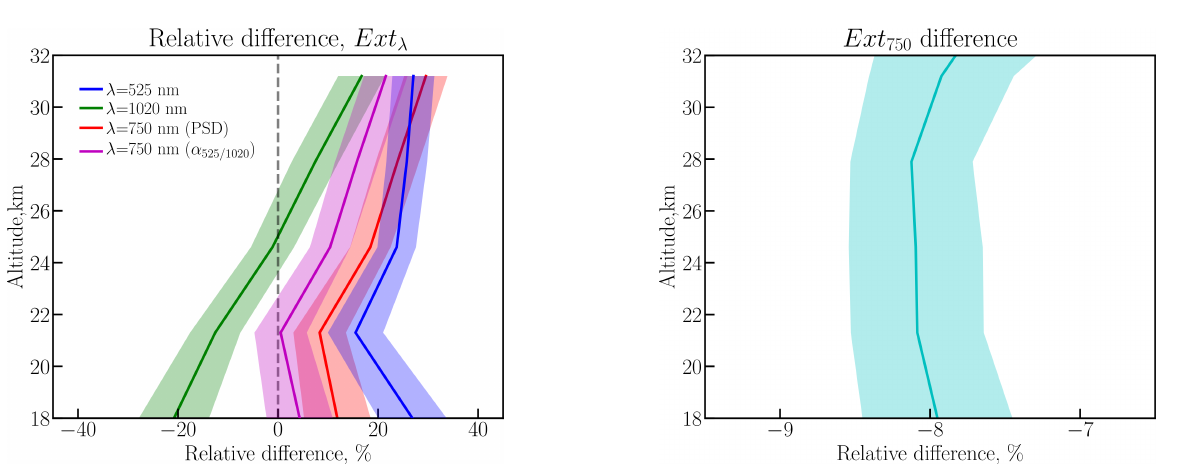
Figure 6. Mean relative difference between Ext 750 ( PSD ) obtained from the PSD product with Eq. (3) and Ext 750 (α 525 / 1020 ) cal- culated using the Ångström exponent (100 × (Ext 750 (α 525 / 1020 ) - Ext 750 ( PSD ) )/Ext 750 ( PSD ) ) from all available SCIAMACHY measurements. The shaded area shows the ± 1 standard